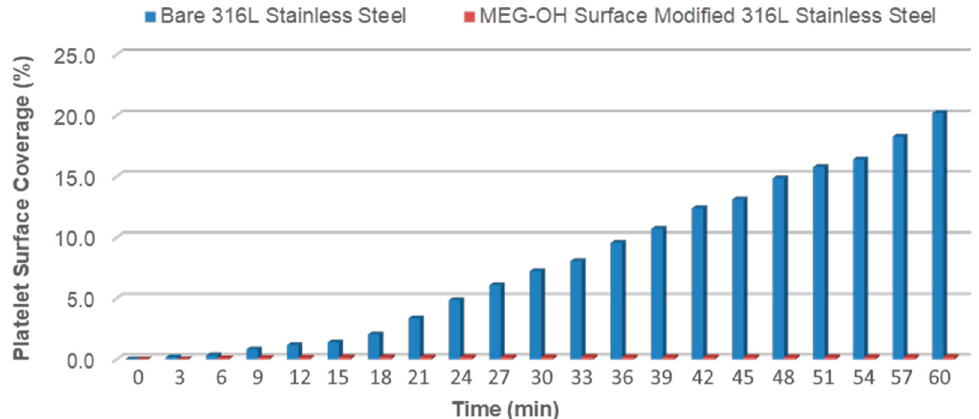
Figure 8. Real-time platelet surface percentage coverage on bare and MEG-OH-modified 316L stainless steel during 60 min blood perfusion at 600 s − 1 shear rate.